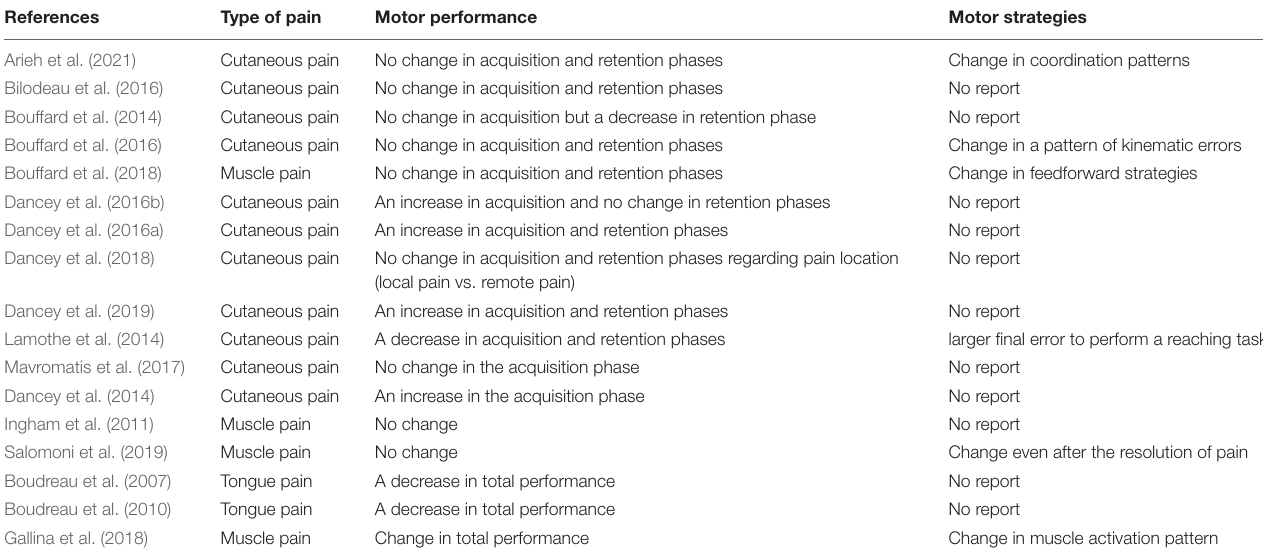
TABLE 3 | Synthesized results of the included